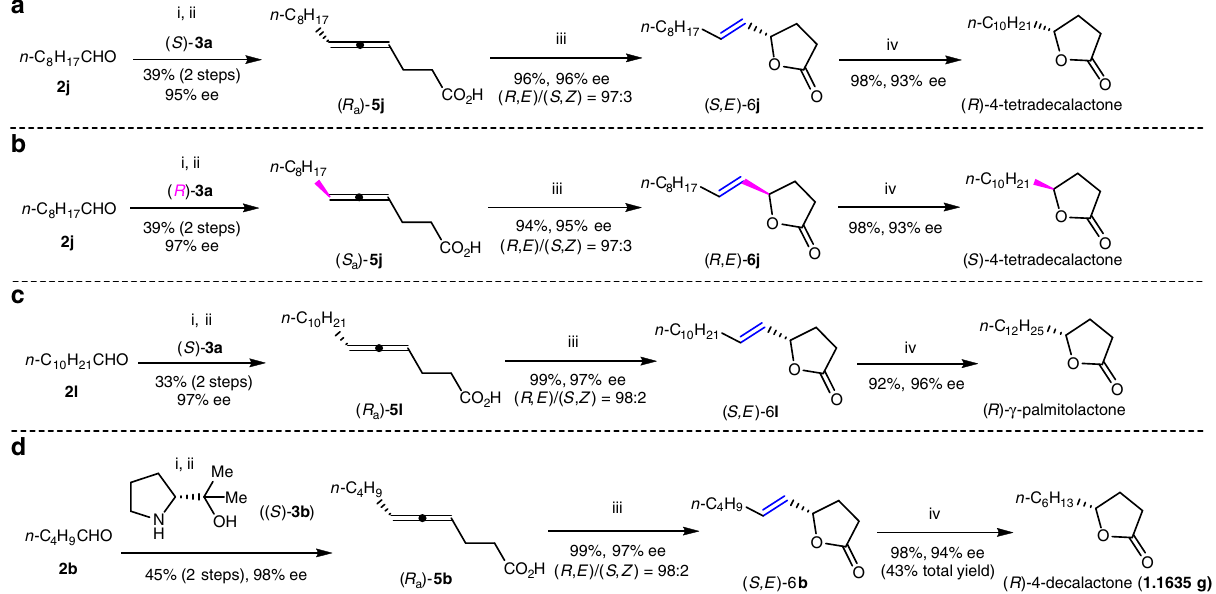
Fig. 7 Synthesis of biologically active aliphatic γ -butyrolactones. a Synthesis of biologically active ( R )-4-tetradecalactone; b Synthesis of biologically active ( S )-4-tetradecalactone; c Synthesis of biologically active ( R )- γ -palmitolactone; d Synthesis of biologically active ( R )-4-decalactone. Reagents and conditions: i. ethyl pent-4-ynoate 1b (1.2 equiv.), 2 (1.5 equiv.), 3 (1.0 equiv.), CuBr 2 (20 mol%), dioxane, 120 °C; ii. LiOH ∙ H 2 O (1.5 equiv.), EtOH/H 2 O =